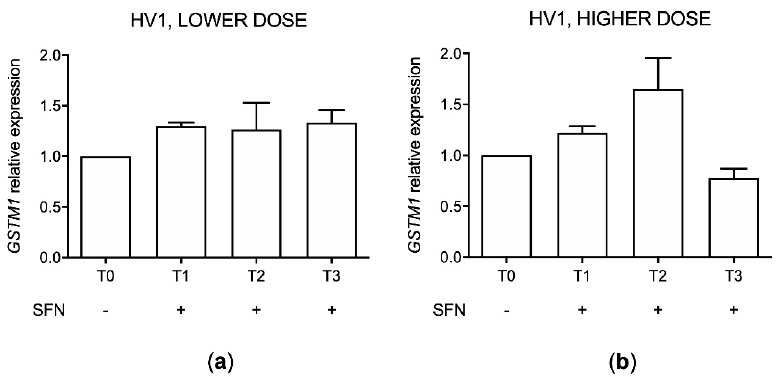
Figure 10. GSTM1 expression in the first healthy volunteer (HV1) after sulforaphane (SFN) supple- ment consumption at 12.6 mg for the first day (T1), 25.2 mg for the second and third days (T2) and 25.2 mg for further seven days (T3) ( a ) and 90 mg/day for three days ( b ). Data are reported as 2 − ∆∆ Ct values considering the no assumption samples (T0) as calibrators and using GAPDH housekeeping gene as reference.